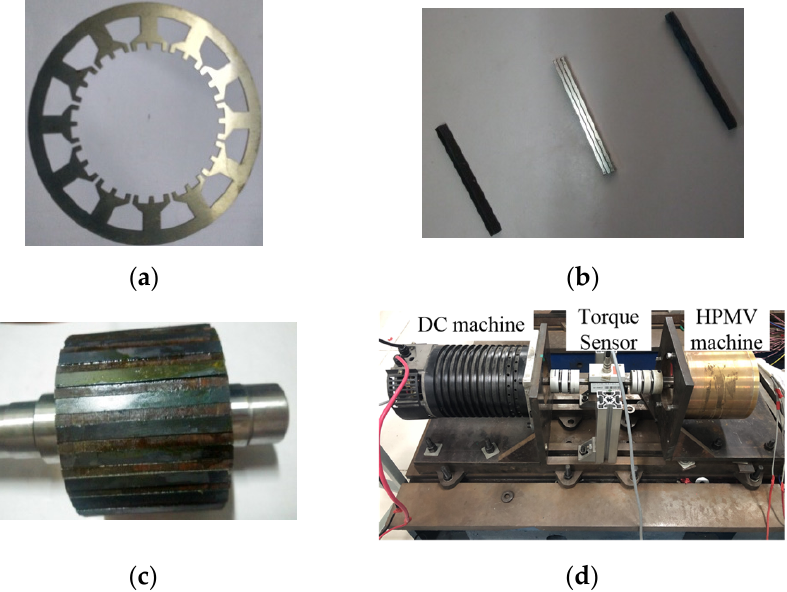
Figure 21. Prototype of the proposed machine. ( a ) Stator lamination. ( b ) Rotor. ( c ) PMs. ( d ) Experiment platform.